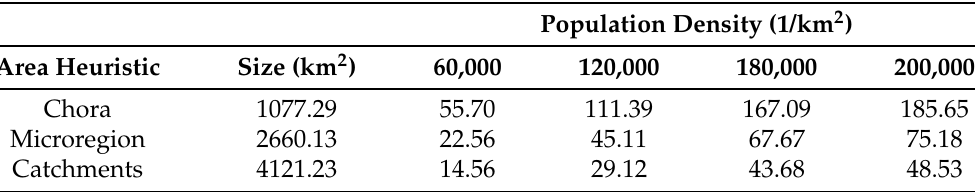
Table 1. Area and populations densities of the complementary regions for different population sizes.